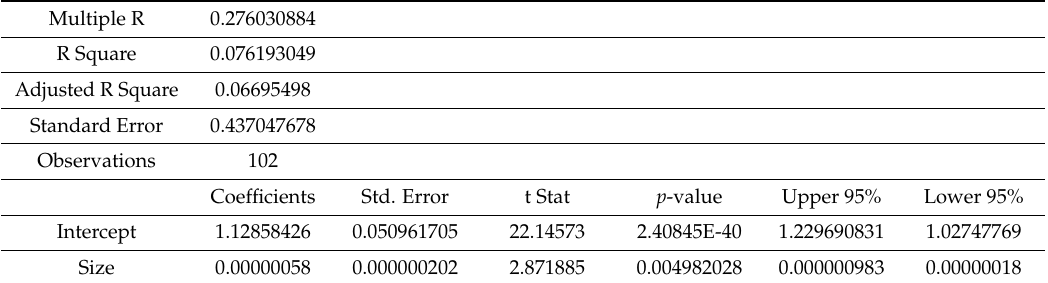
Table 4. Size of green infrastructure project versus number of financial